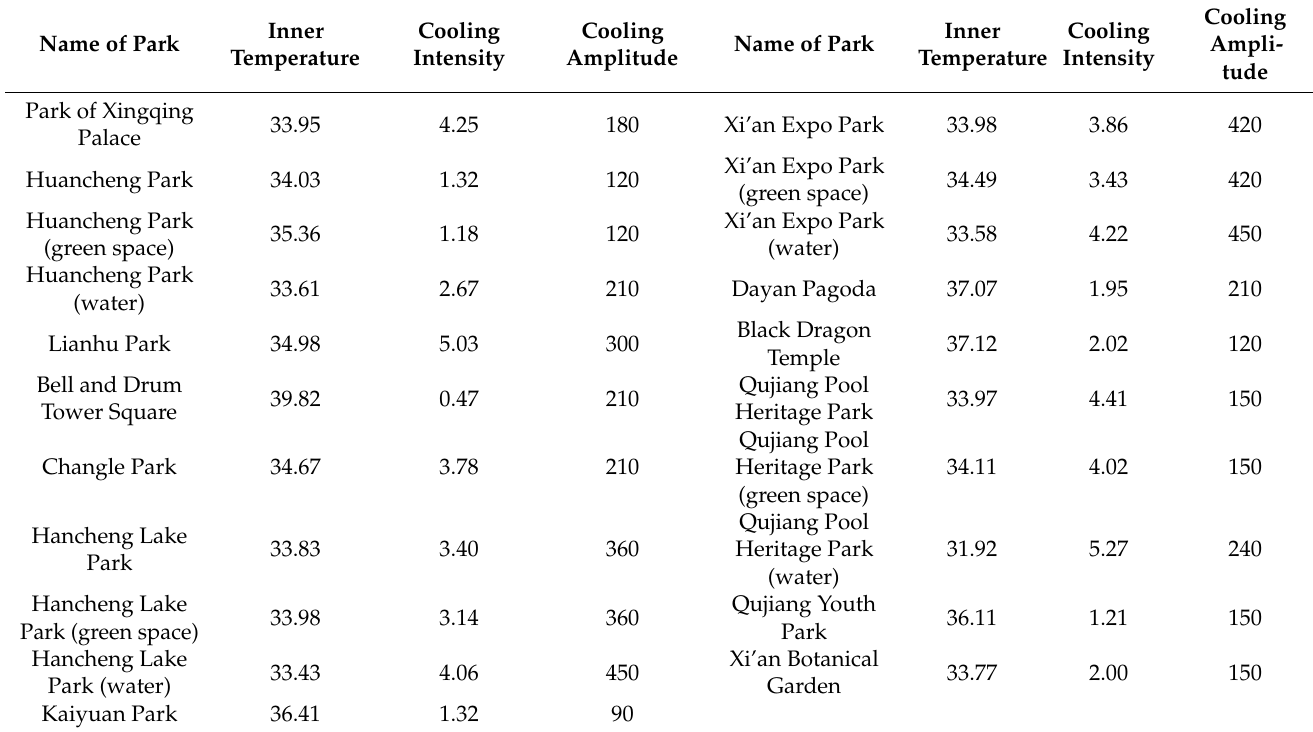
Table 3. Average inner temperature, cooling intensity ( ◦ C), and cooling amplitude (m) of typical urban